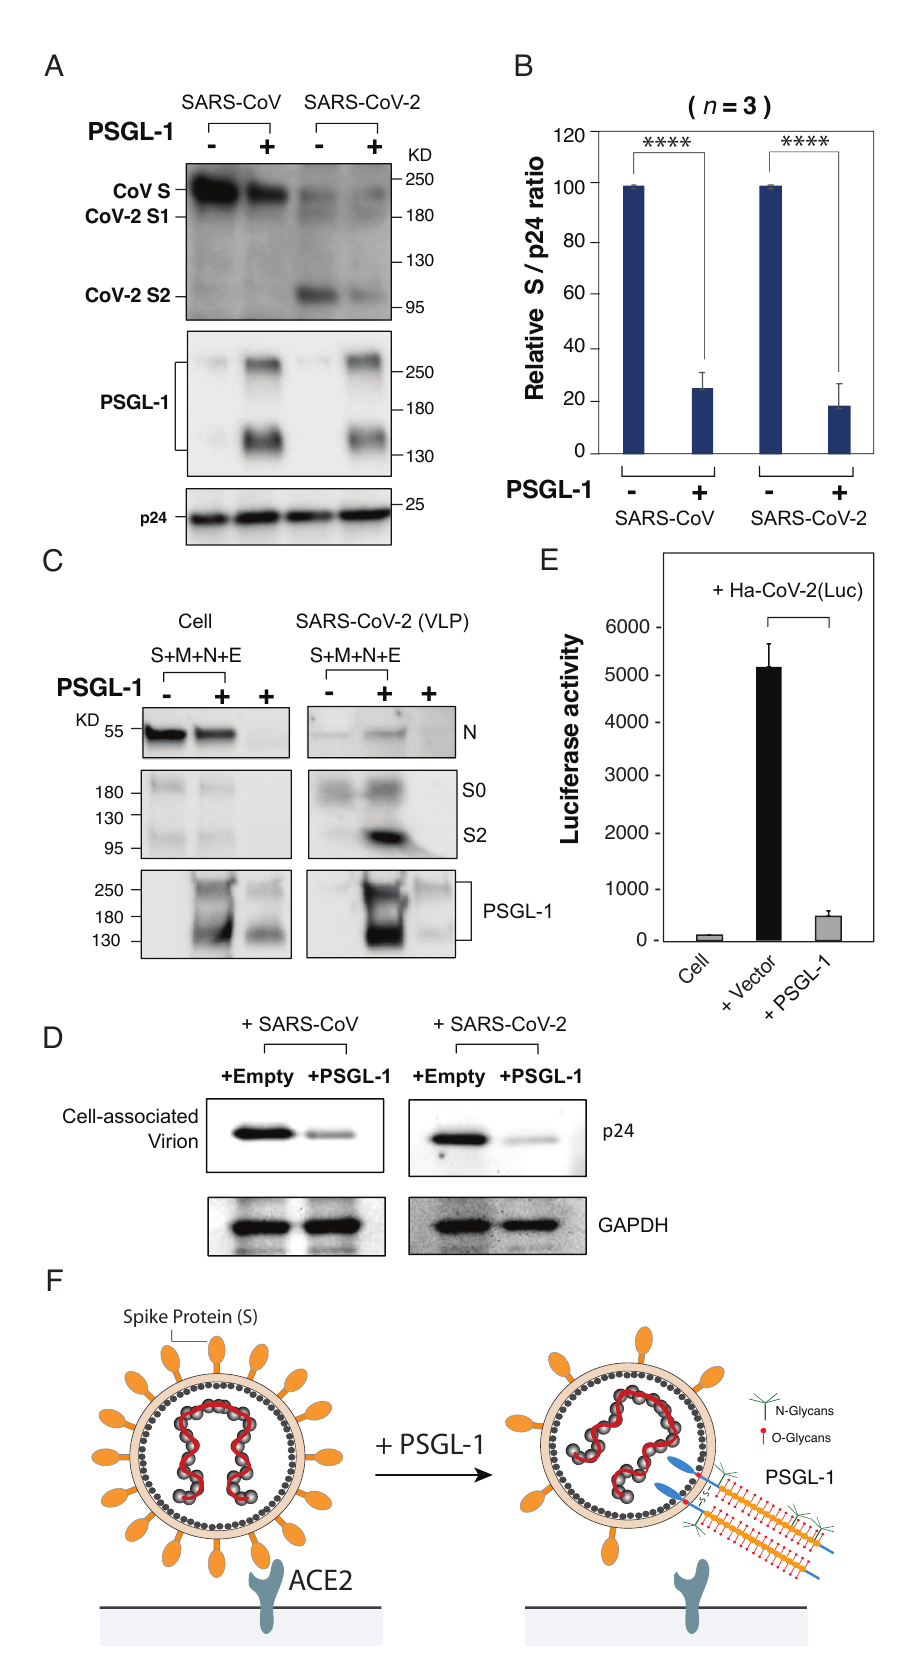
Figure 2. PSGL-1 inhibits the binding and entry of virus-like particles (VLPs) bearing SARS-CoV and SARS-CoV-2 S proteins. ( A ) PSGL-1 inhibits the incorporation of S proteins into lentiviral